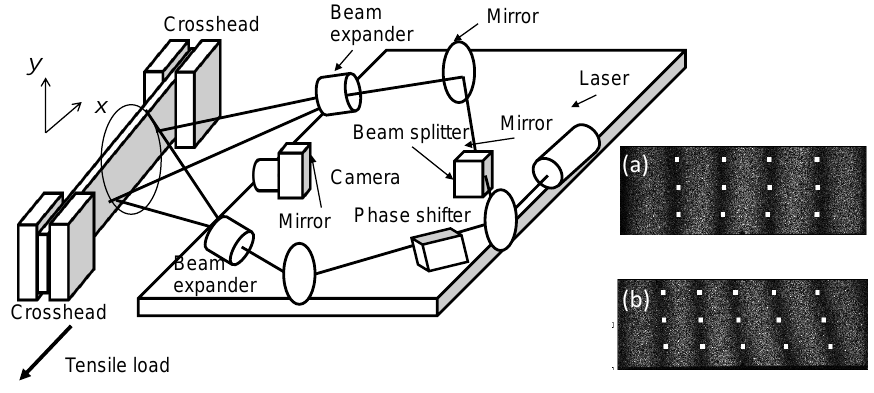
Figure 4. Optical arrangement for the electronic speckle-pattern interferometry (ESPI) setup. The illustration is for the x interferometer sensitive to the in-plane displacement component parallel to the tensile axis. An identical configuration for the x -component of the in-plane displacement called